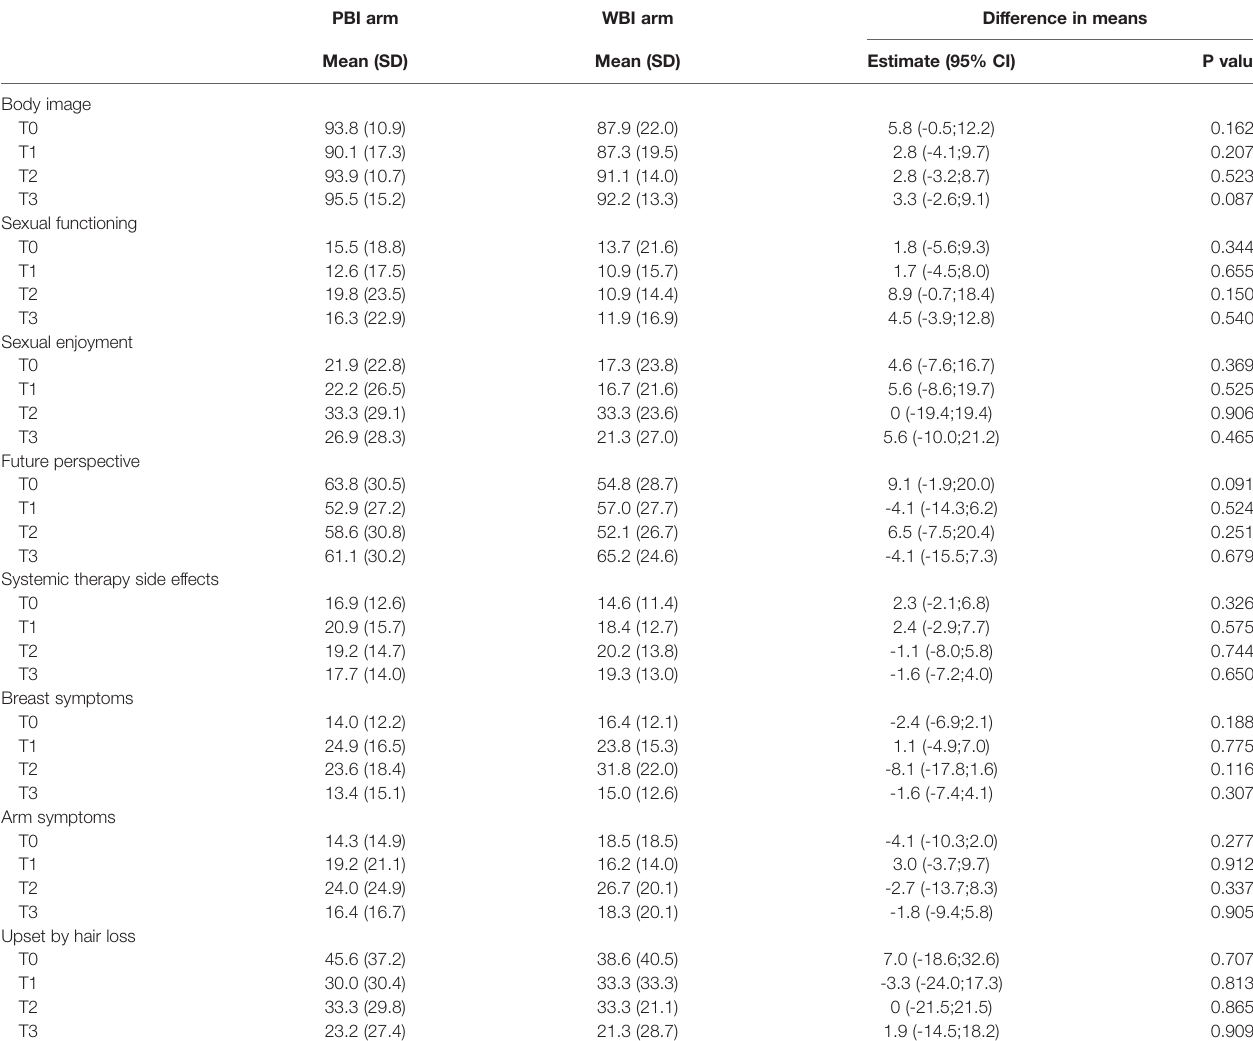
TABLE 3 | Mean scores (and SD) of EORTC QLQ-BR23 at T0, T1, T2, and T3 between the two arms. PBI arm WBI arm Difference in